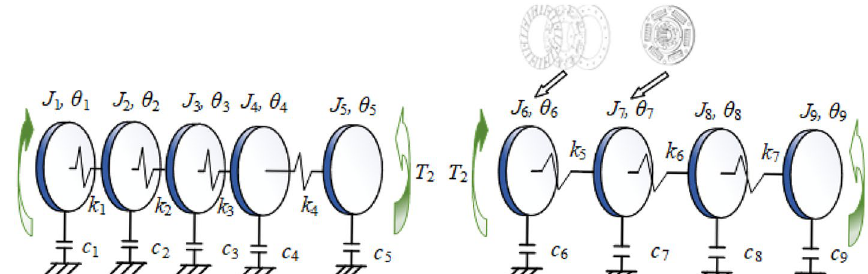
Figure 2 Dynamic model in slipping